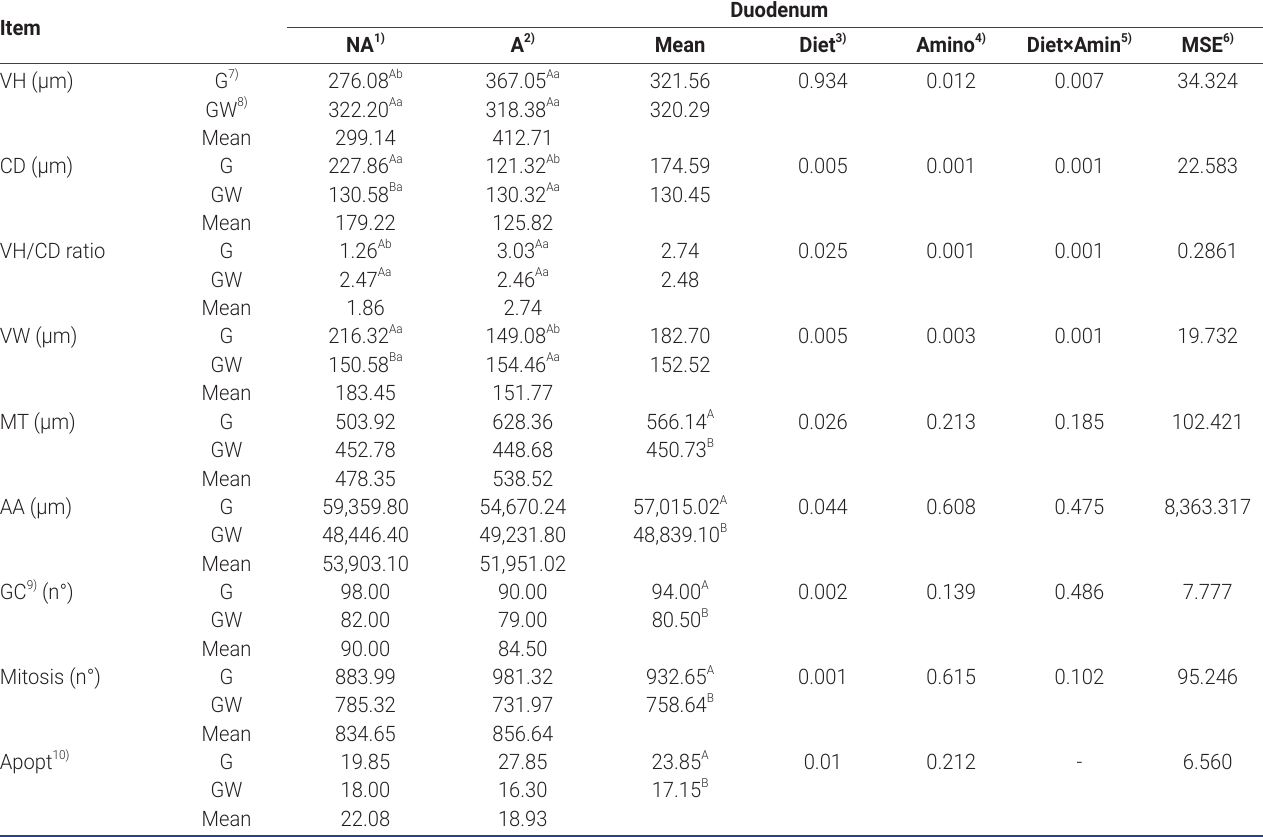
Table 3. Intestinal morphometry, mitosis rate and apopitosis in the duodenal epithelium of piglets fed diets supplemented with L-glutamine + L-glutamic acid in diets with or without whey powder